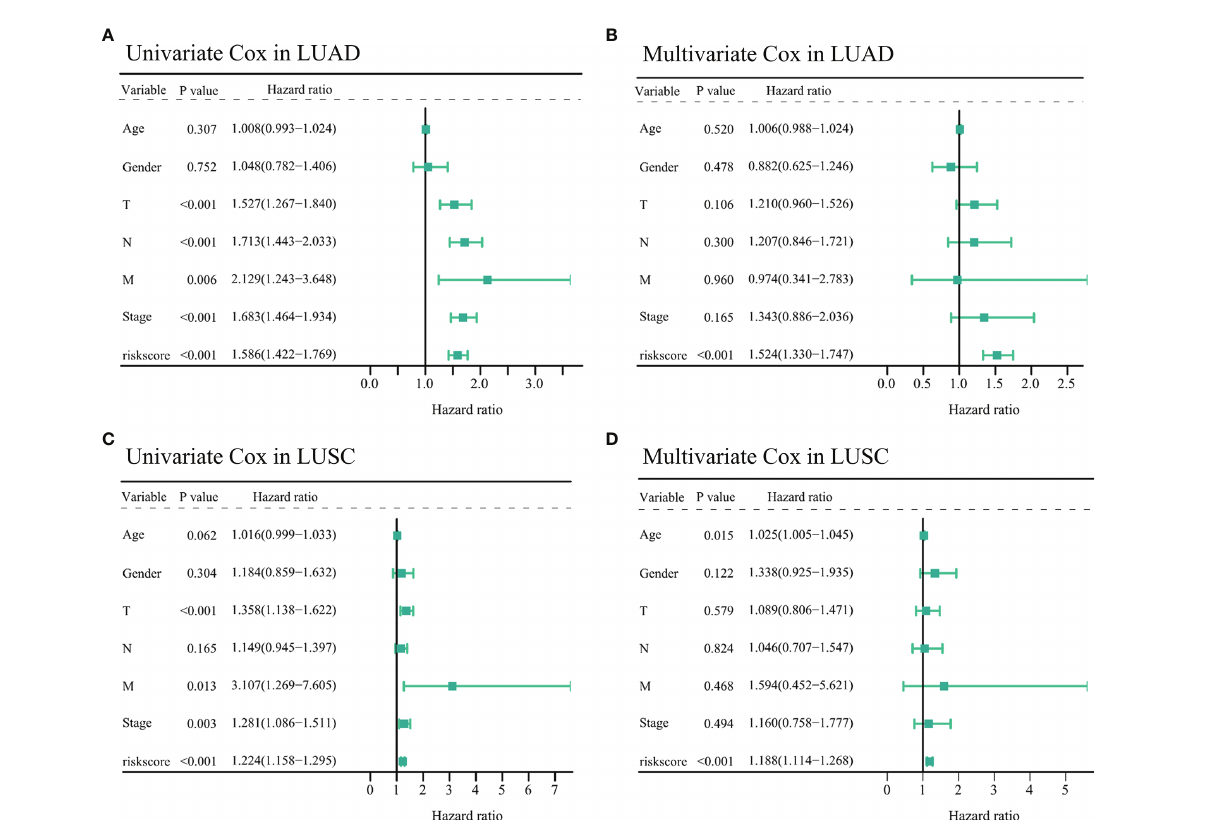
FIGURE 6 | Assessing the prognostic values of the two IFI44L -related immunomodulator signatures in TCGA-NSCLC cohorts. (A, B) Univariate (A) and multivariate (B) Cox regression analysis of the risk score in the TCGA-LUAD cohort. (C, D) Univariate (C) and multivariate (D) Cox regression analysis of the risk score in the TCGA-LUSC cohort. TCGA, The Cancer Genome Atlas; NSCLC, non-small cell lung carcinoma; LUAD, lung adenocarcinoma; LUSC, lung squamous cell